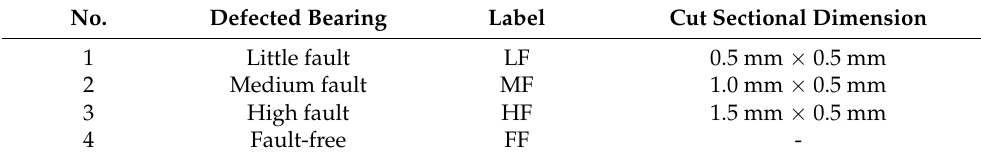
Figure 3. Faulty bearing on the outer ring. Table 3. Details for the defected bearings in artificial damage.